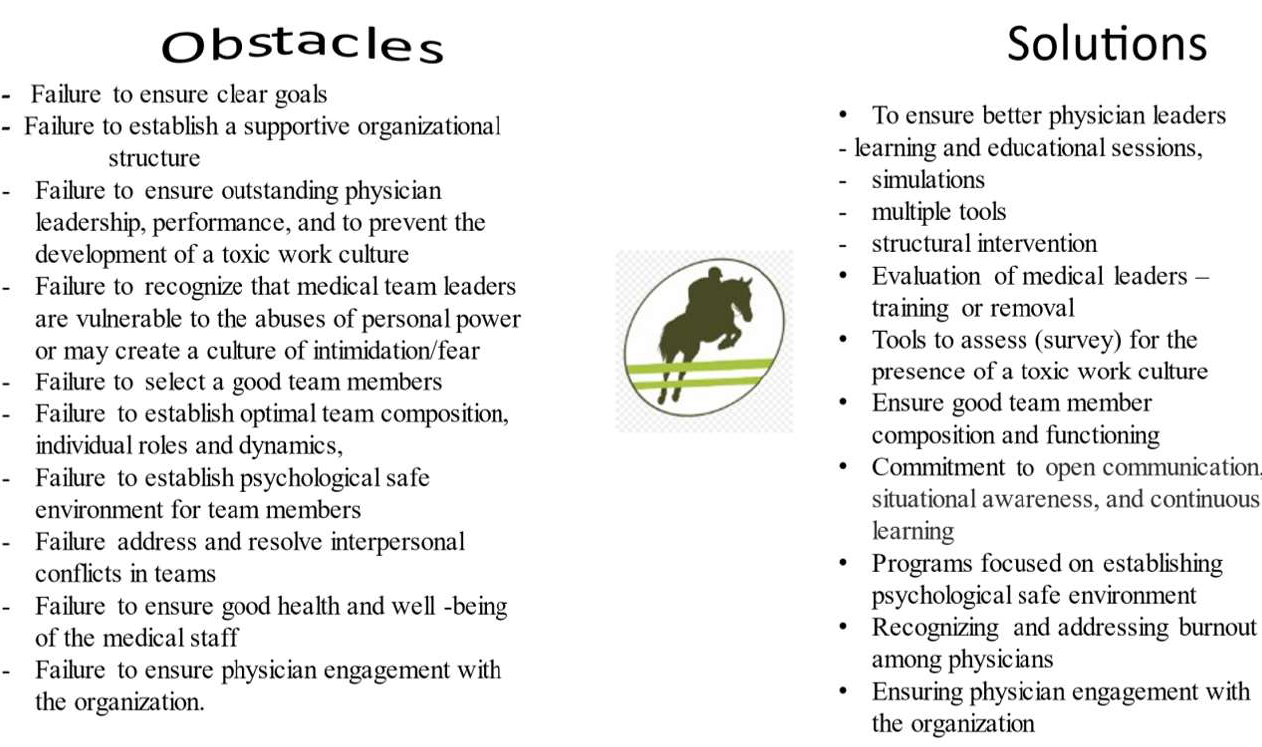
Figure 2. Graphical representation of the process of overcoming obstacles to develop high-performance teams involving physician in health care organizations.